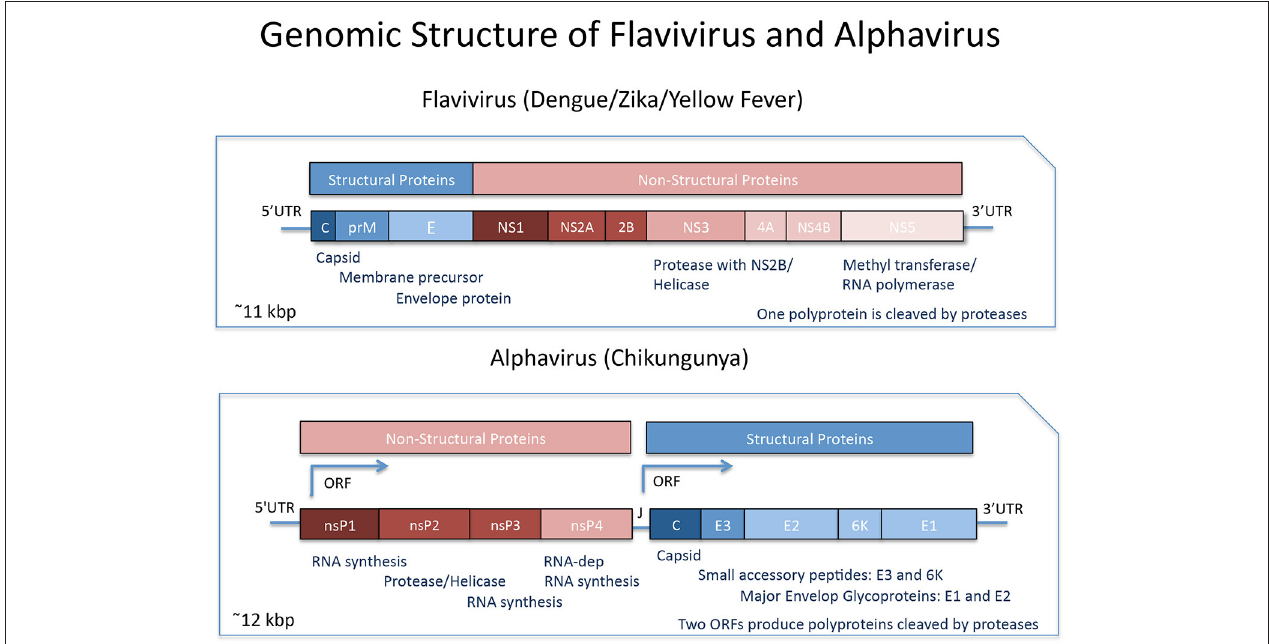
FIGURE 1 | Genomic Organization of Flavivirus and Alphavirus. Flavivirus comprise a single Open Reading Frame with the genes for the Structural Proteins followed by the Non-Structural Proteins transcribed and translated and the resulting polyprotein undergoes proteolytic processing. Alphavirusus are comprised of the genes for the Non-Structural Proteins followed by the Structural Proteins, transcribed from two distinct ORFs, and each resulting polyprotein undergoes further proteolytical processing. Modified from Shi and Gao (2) and Powers et al.